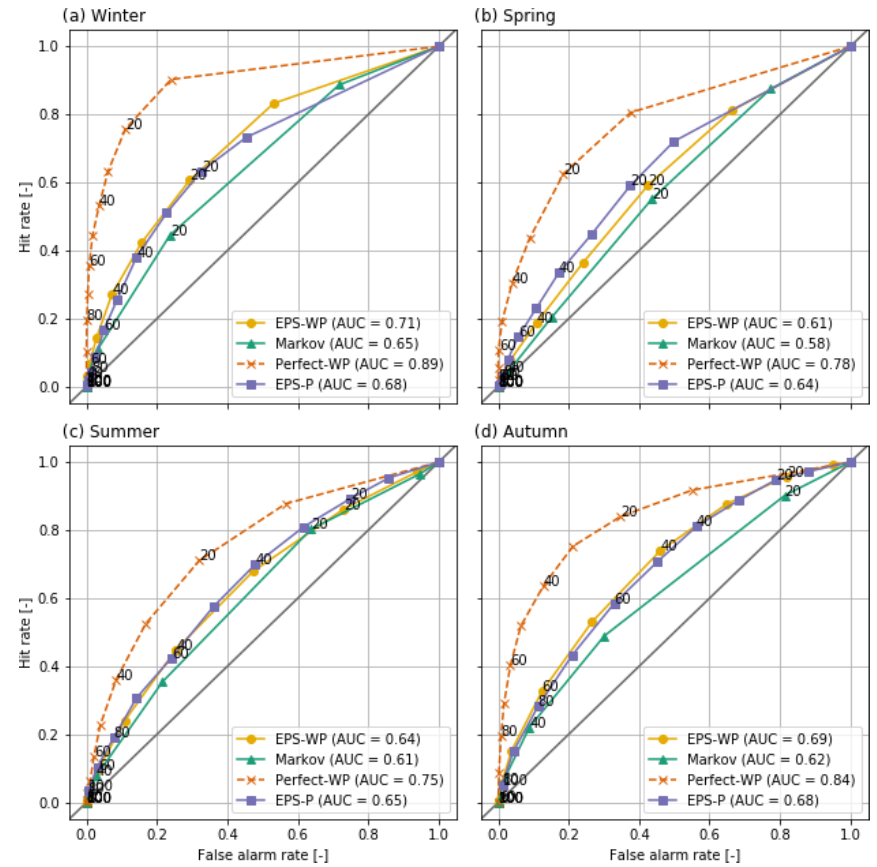
Figure 8. Relative operating characteristic (ROC) curves and area under ROC curve (AUC) for mild drought with a 46d lead time. Annotated values indicate drought forecast probability